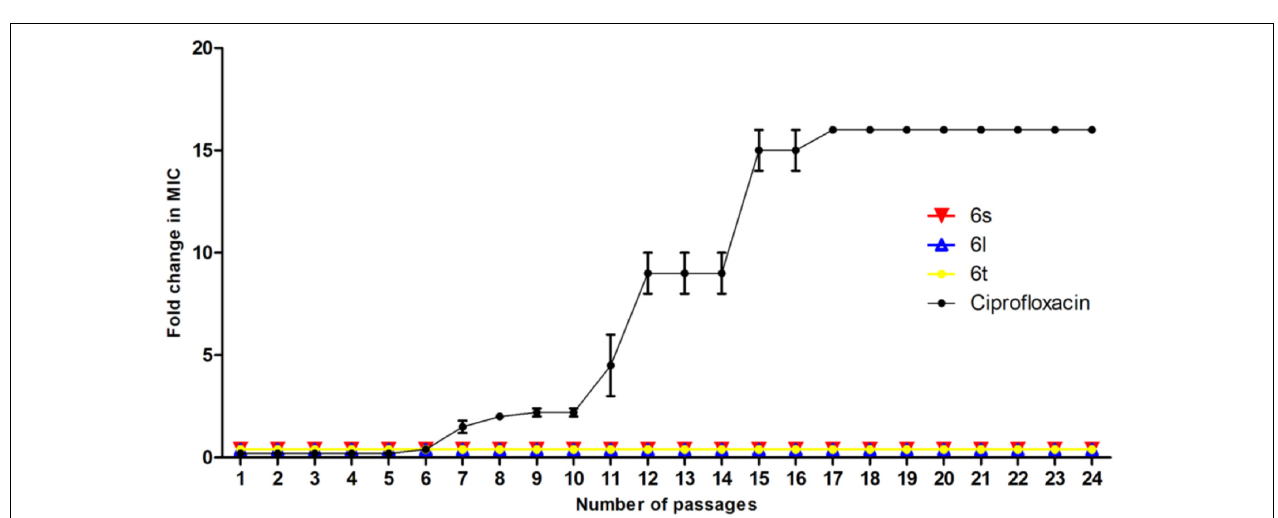
FIGURE 5 | Multistep resistance during serial passaging in the presence of sub-MIC levels: MRSA-3 was grown at sub-MIC levels of test compound or control antibiotic ciprofloxacin. Cultures with positive growth at highest treatment concentration were used the next day to inoculate media at increasing increments of indicate compound. Experiment was conducted for 24 days and results are average of 3 independent